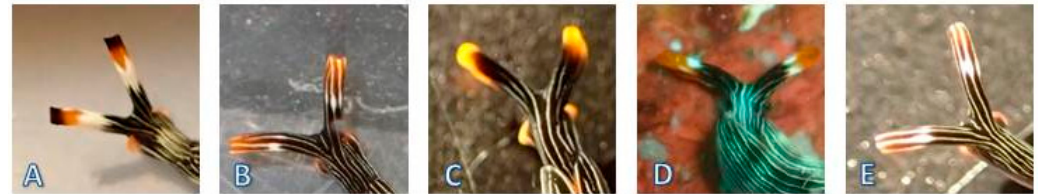
Figure 5. Variability of rhinophores in the Thuridilla gracilis species complex from Bangka Archipelago: ( A ) Thgr18Ba1; ( B ) Thgr17Ba-3; ( C ) Thgr18Ba4; ( D ) Thgr18Ba6; ( E ) Thgr18Ba-5.